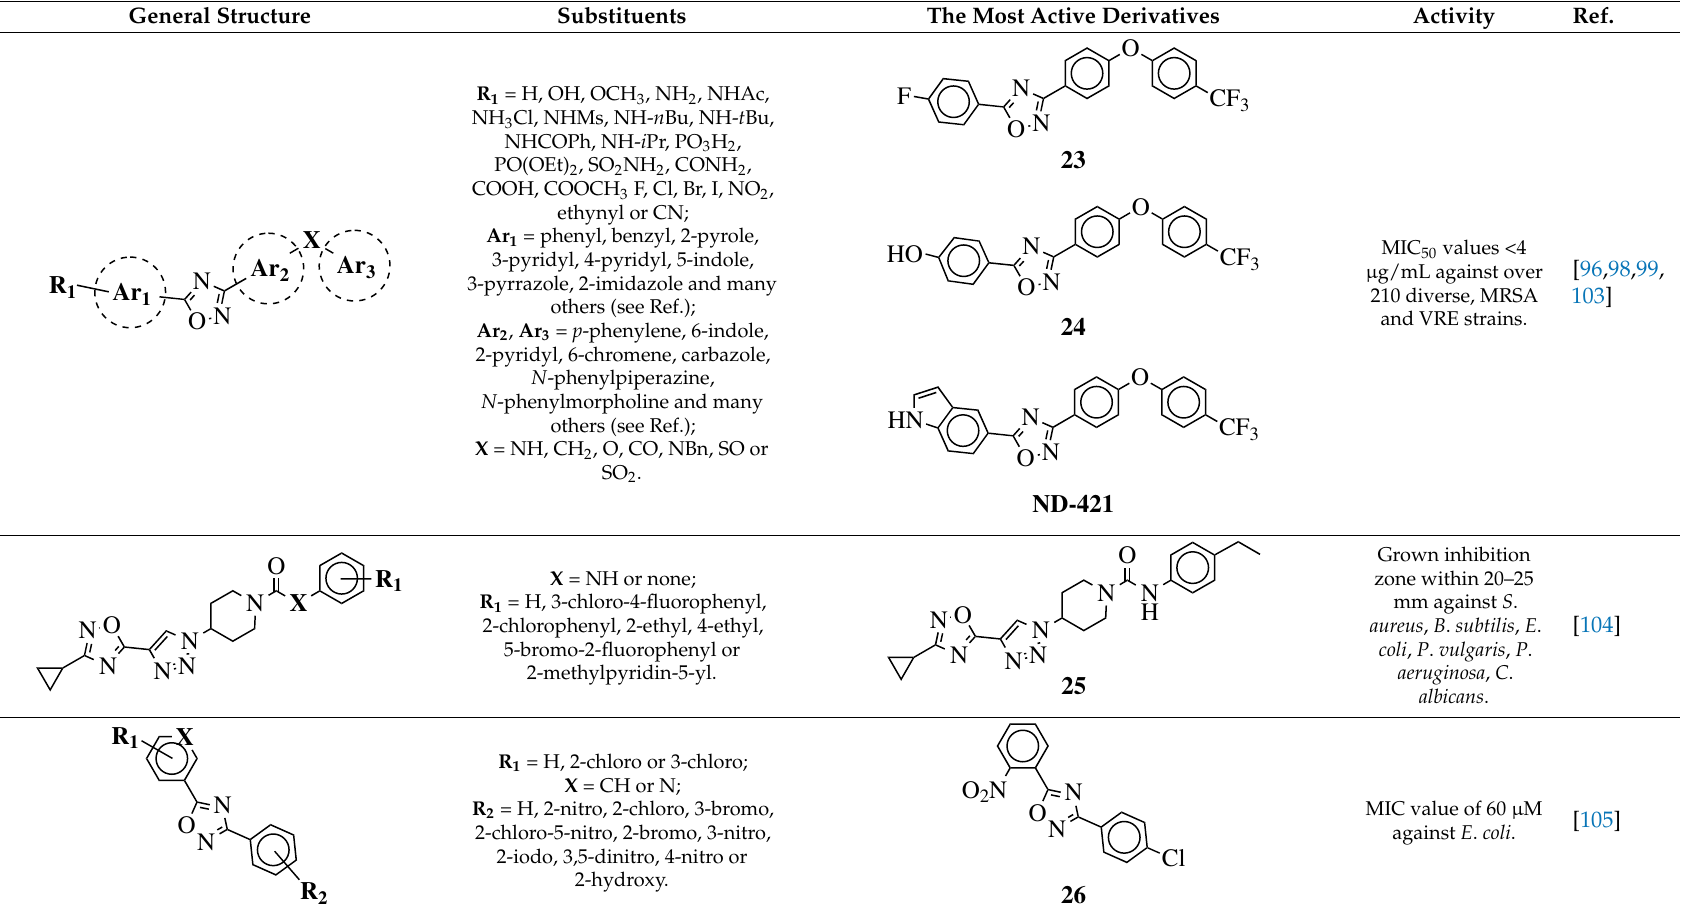
Table 3. 1,2,4-oxadiazole derivatives and their antimicrobial